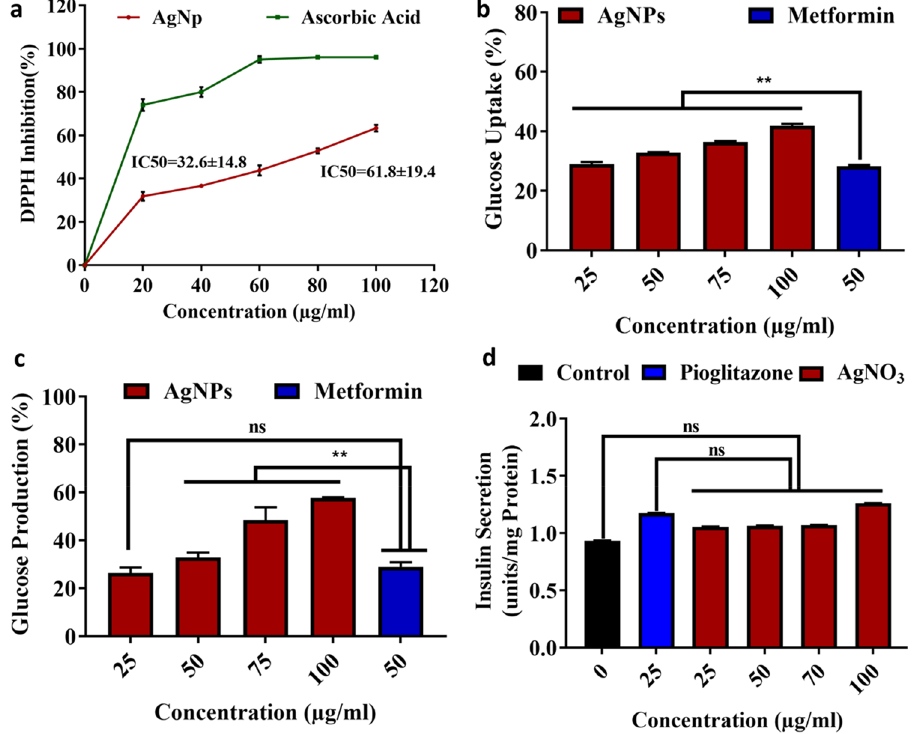
Figure 4. Activity of the AgNPs synthesized from A.sativum extract ( a ) Antioxidant activity (IC50: Concentration of the sample caused 50% DPPH radical scavenging ability), ( b ) Effect of AgNPs on glucose uptake in L-6 cell line, ( c ) Effect of AgNPs on glucose production in L-6 cell line and ( d ) Effect of AgNPs on Insulin secretion in pancreatic cells . ( Data was represented as mean ± SD * P < 0.05; ** P < 0.005; ns-